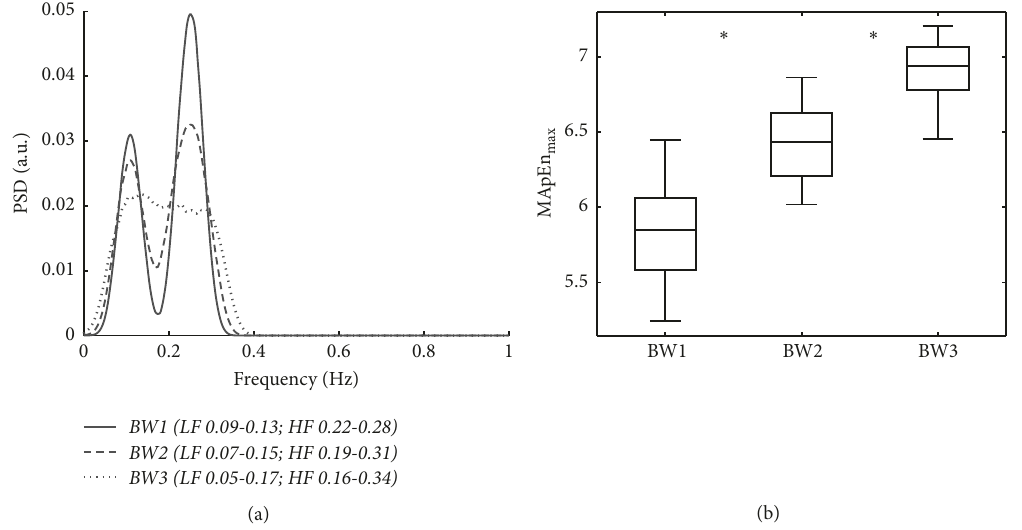
Figure 5: (a) Median spectrum and (b) 𝑀𝐴𝑝𝐸𝑛 𝑚𝑎𝑥 values obtained per type of filtered white noise time series. ∗ indicates statistically significant differences by Mann-Whitney U test ( p -values < 0.05). Data are shown as median and interquartile range over 30